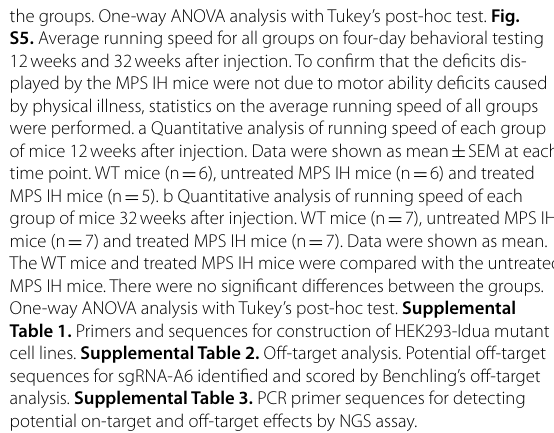
Table 1. Primers and sequences for construction of HEK293-Idua mutant cell lines. Supplemental Table 2. Off-target analysis. Potential off-target sequences for sgRNA-A6 identified and scored by Benchling’s off-target analysis. Supplemental Table 3. PCR primer sequences for detecting potential on-target and off-target effects by NGS